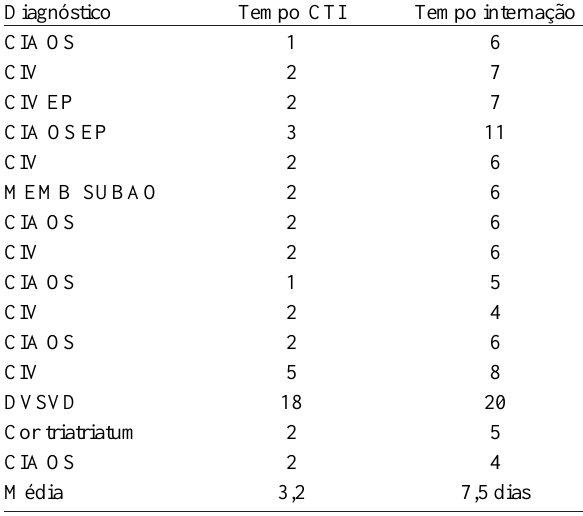
Tabela 4. Tempo de internação em CTI e